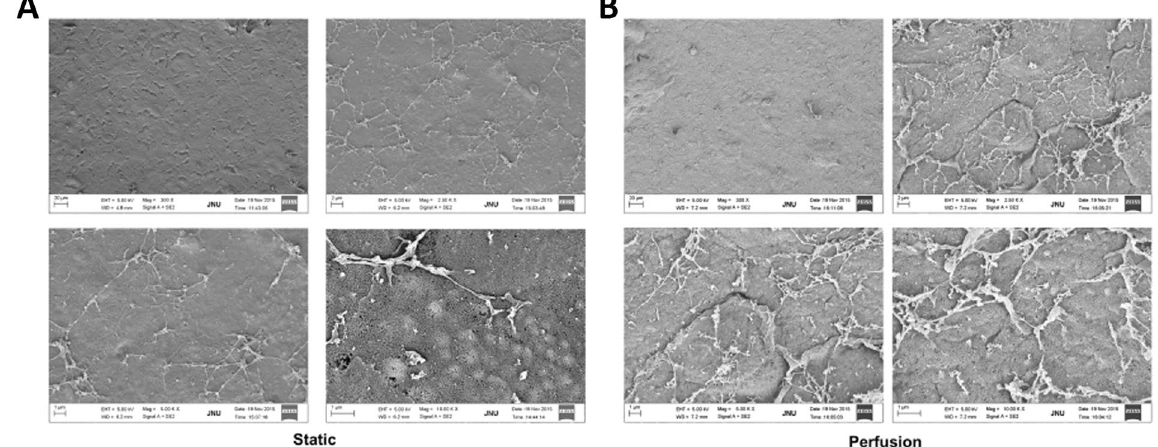
Figure 6. CEC spheroids cultured on decellularized corneal scaffolds in the static and perfusion system. SEM images of CECs on decellularized corneal scaffolds in the static ( A ) and perfusion ( B )